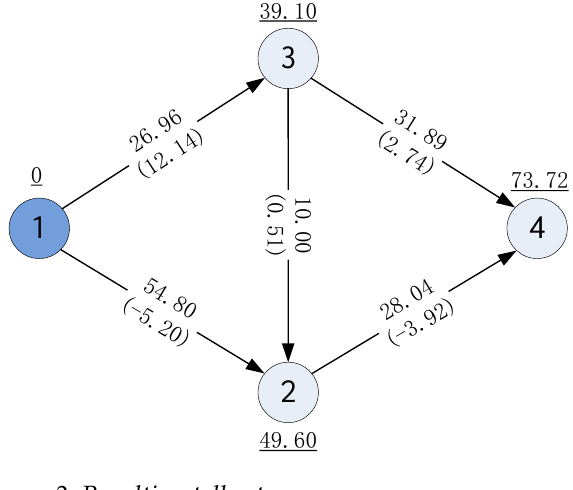
Figure 2 Resulting toll